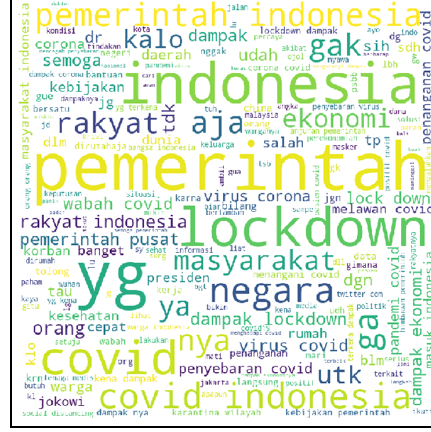
Fig. 6 The word cloud of